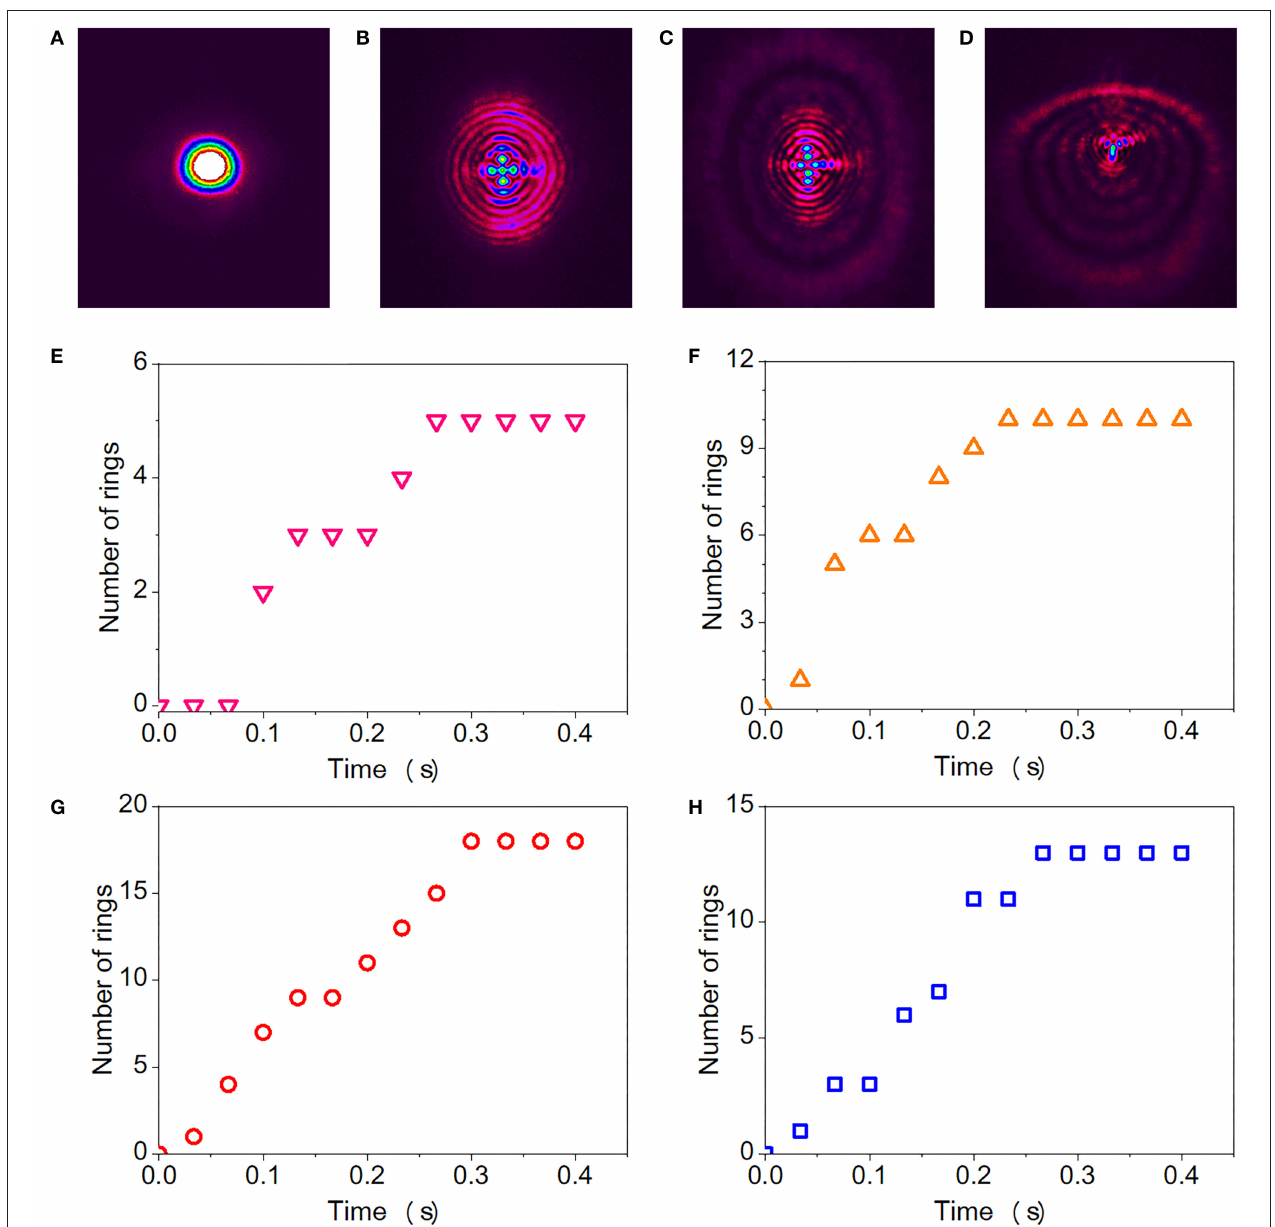
FIGURE 3 | (A–D) Formation process of SSPM patterns at (A) 0s, (B) 0.07s, (C) 0.53s, (D) 1s at a wavelength of 1,300nm (laser beam intensity I = 31.8 W/cm 2 ). (E–H) Number of rings N changing with the time at a wavelength of (E) 1,550nm, (F) 1,300nm, (G) 800nm, (H) 400nm,